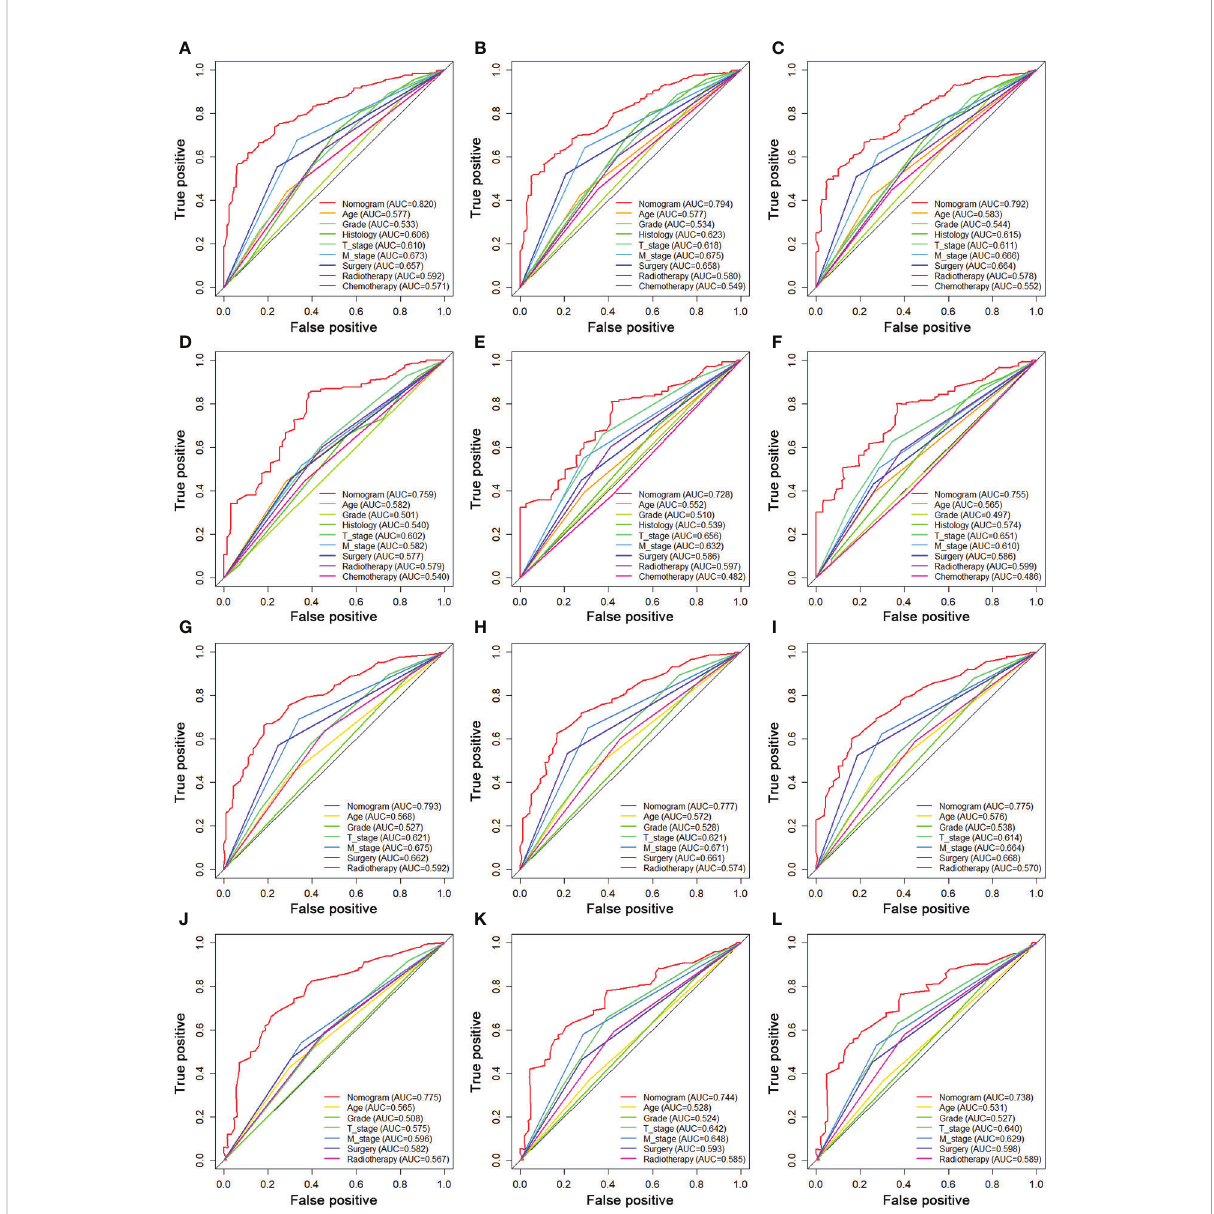
FIGURE 9 Comparison of AUC between prognostic nomogram and all predictors of 24- (A) , 36- (B) , and 48-month (C) OS in the training set and of 24- (D) , 36- (E) , and 48-month (F) OS in the testing set. Comparison of AUC between prognostic nomogram and all predictors of 24- (G) , 36- (H) , and 48-month (I) CSS in the training set and of 24- (J) , 36- (K) , and 48-month (L) CSS in the testing